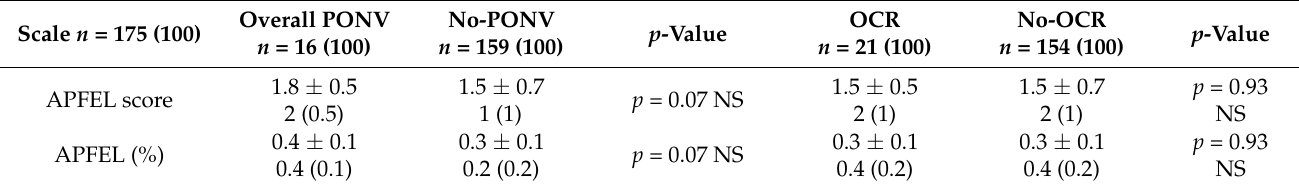
Table 2. Apfel score in patients according to presence of PONV and OCR.